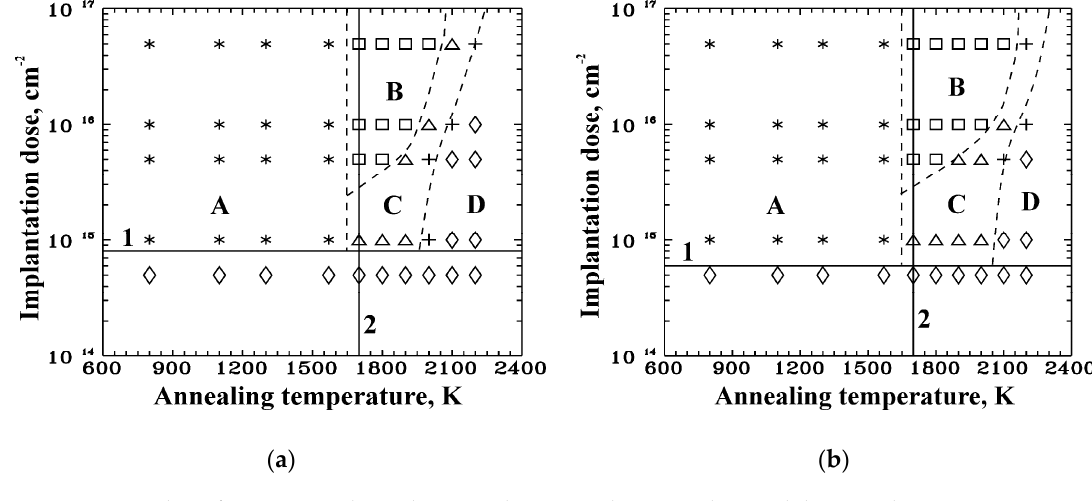
Figure 1. Phase formation in dependence on the ion implantation dose and the annealing temperature of ion-implanted and RTP-annealed C-face (0001 ) -oriented 6H-SiC: ( a ) Al + at 80 keV; ( b ) Ar + at 80 keV; *—partial recrystallized and 1D-disordered SiC, (cid:3) —3C-SiC and polycrystalline 3C-SiC; ∆ —twinned 3C-SiC; + —6H and 3C-SiC; ♦ —6H-SiC. Horizontal solid line 1 ( ______ ) indicates the dose necessary for the formation of an amorphized region reaching the substrate surface. The vertical solid line 2 ( ______ ) shows the temperature above which the formation of 1D-disordered structures was not observed. The borders between di ff erent phases formed in the near-surface region of the ion-implanted and annealed 6H-SiC are indicated by dashed lines (- - -).